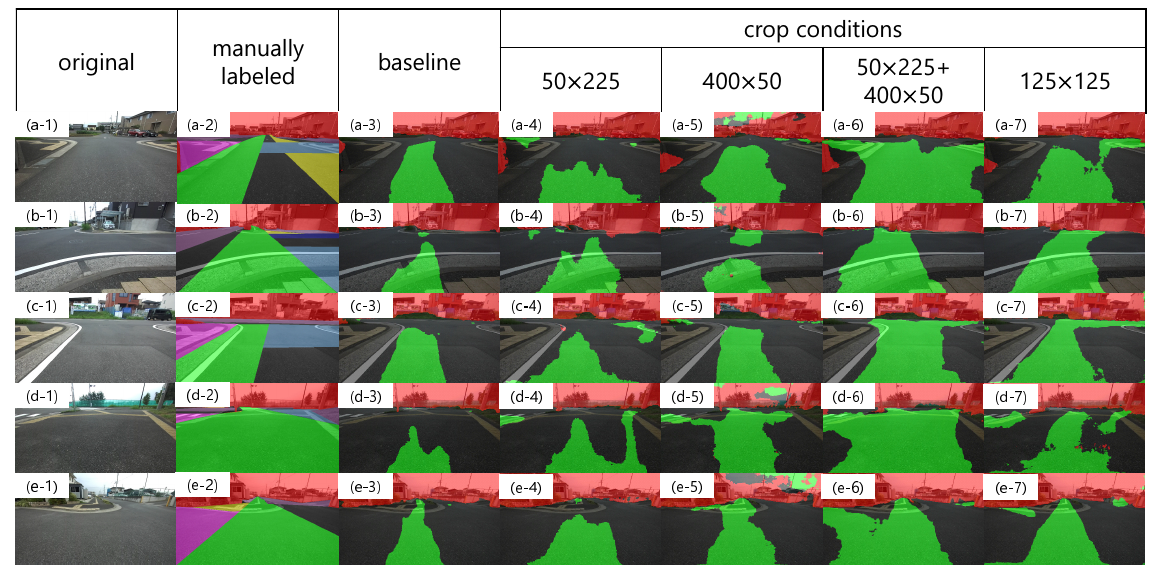
Figure 12. Qualitative comparisons between different crop sizes. ( a-1 )–( e-7 ) are the image numbers referred to in the text.